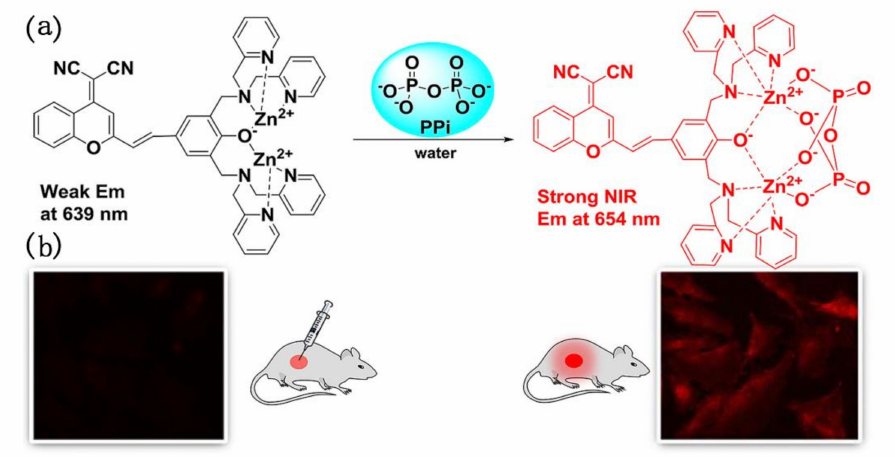
Figure 17. ( a ) The responsive mechanism of sensor 1-2Zn for PPi sensing; ( b ) fluorescent images of PPi in cell and mice with sensor 1-2Zn . Reprinted from [91], Copyright 2018, with permission from